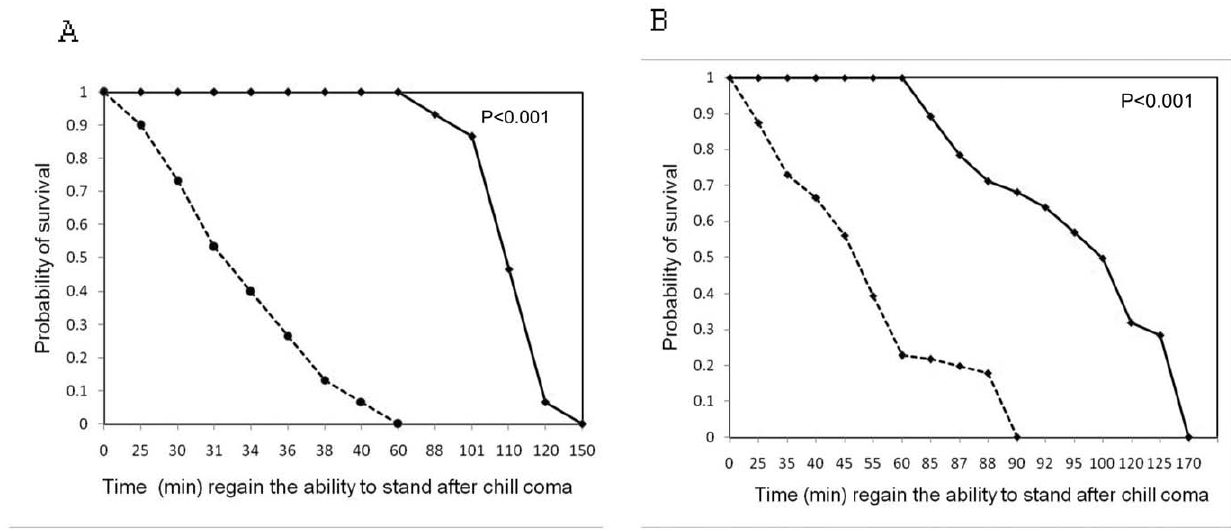
Figure 3. Survival curves for chill-coma recovery in males (A) and females (B) derived from either protein (–) or carbohydrate (- - -) enriched medium.